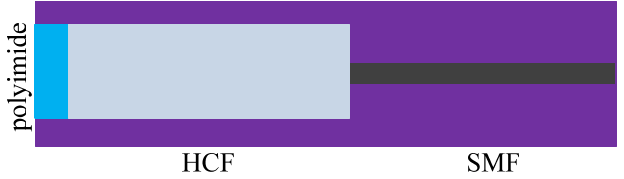
Figure 17. The sensor consists of FBG and salinity fiber [84].